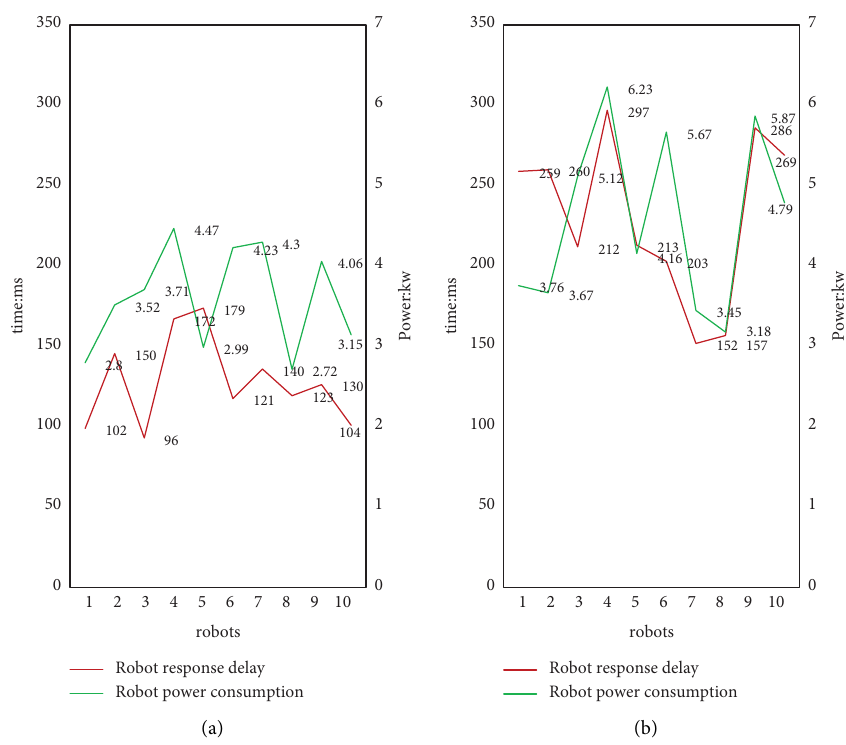
Figure 4: ROS robot performance. (a) Te frst set of experiments. (b) Te second set of